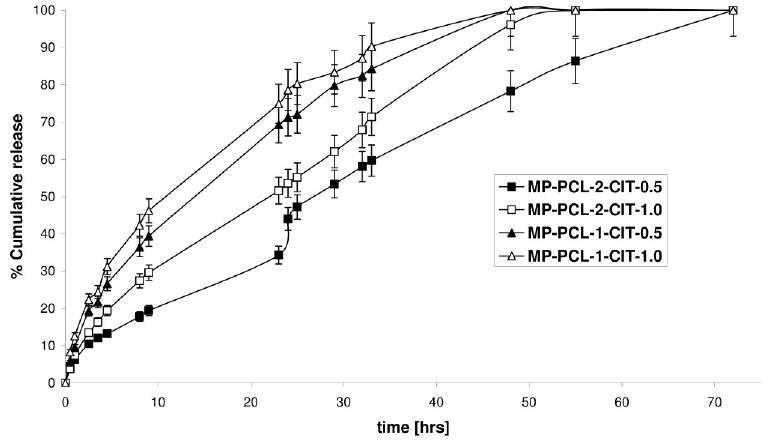
Figure 2. Cumulative release of CIT from the MP-PCL-1-CIT-0.5, MP-PCL-1-CIT-1.0, MP-PCL-2-CIT-0.5 and MP-PCL-2-CIT-1.0 during 72 h (each point represents the mean ± SD of three points).